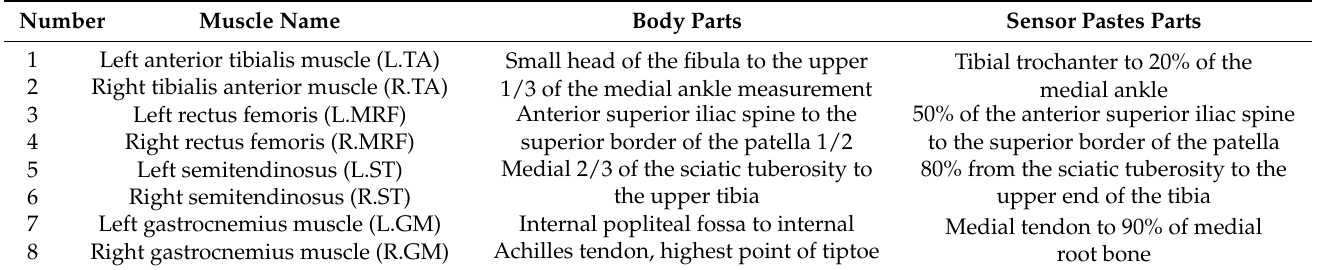
Table 2. Muscle selection name and